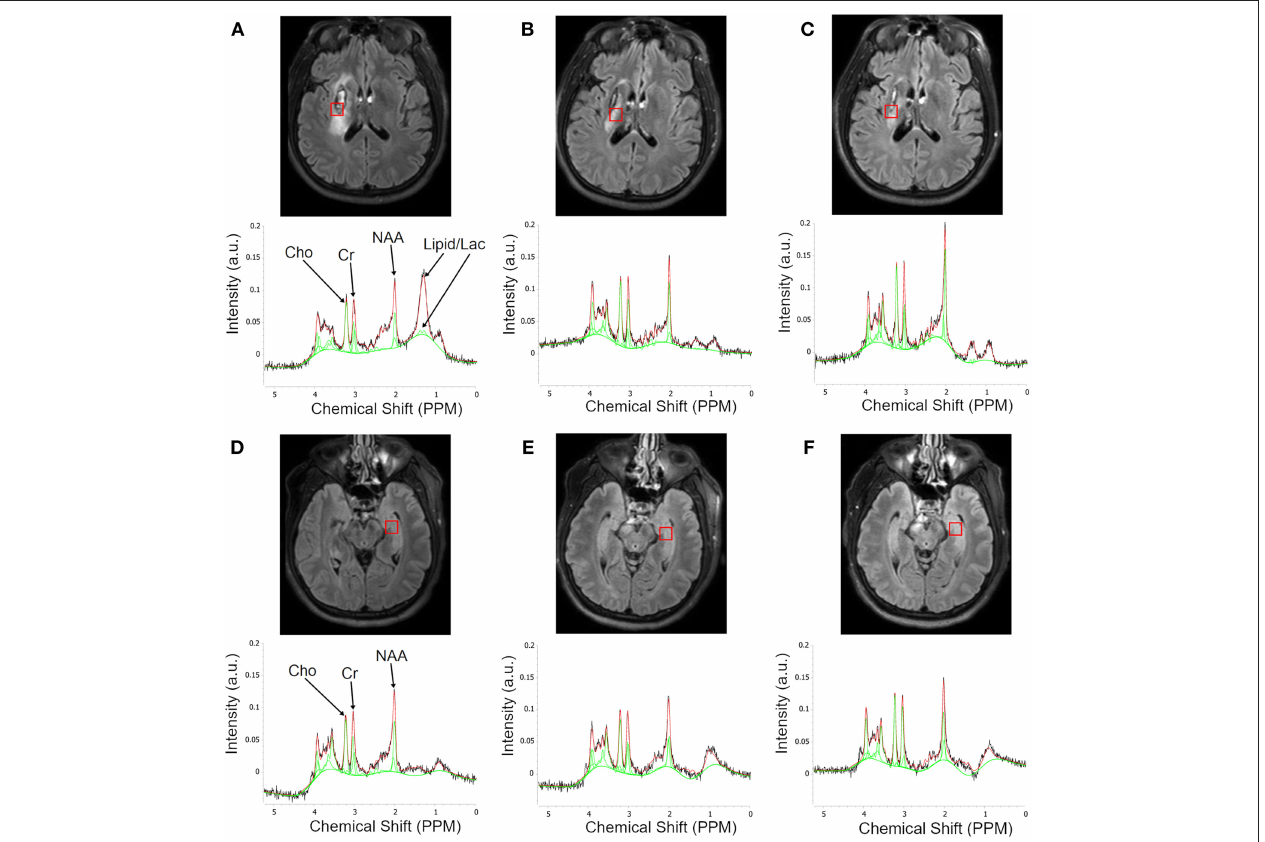
FIGURE 1 | Serial Flair MR images illustrating typical MRS voxel placement in the lesion and contralateral tissues and corresponding MR spectra. The first row of images (A–C) is a single slice showing voxel placement in the lesion at 1, 3, and 6 months, respectively. The second row shows the corresponding spectra within the lesion. Each plot shows the raw spectrum (black), library spectra of matching metabolites (red), and fitted function (green). Third row (D–F) shows voxel placement in the contralesional gray matter with corresponding spectra in the fourth row. Note the questionable peak at 1.33 ppm at 1 month that disappears at the later time point.